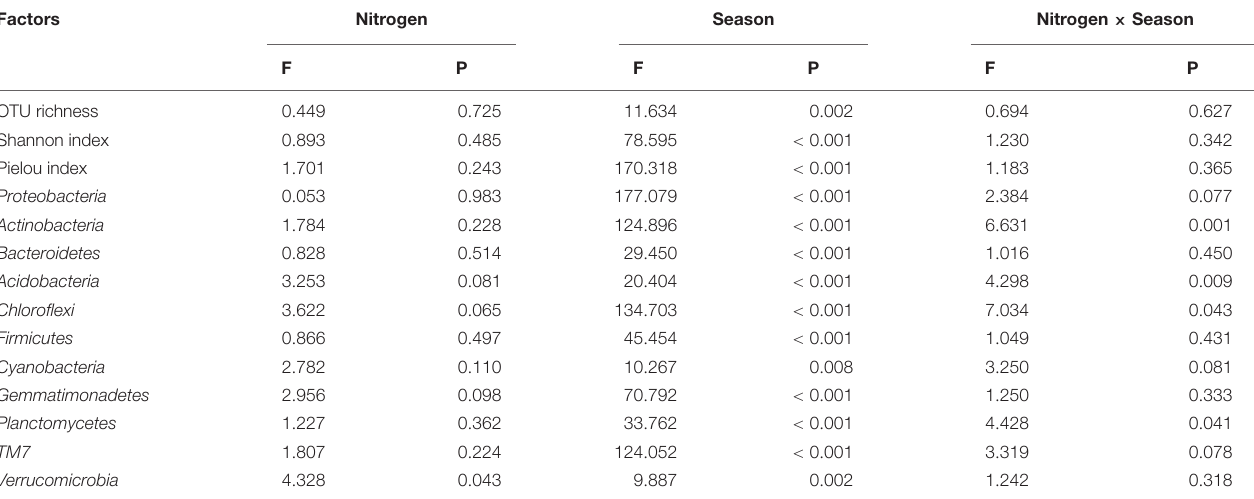
FIGURE 2 | Seasonal changes in soil bacterial OTU richness and diversities in moss crusts with different levels of N additions. OTU richness (A) , Pielou index (B) , and Shannon index (C) . N0 = 0 g N m - 2 year - 1 ; LN = 1.8 g N m - 2 year - 1 ; MN = 3.6 g N m - 2 year - 1 ; HN = 7.2 g N m - 2 year - 1 . Different capital letters indicate a significant difference among the three sampling months with the same concentration of N; different lowercase letters indicate a significant difference among four N treatments in the same sampling month. Vertical bars show the standard error (SE) ( n = 3). TABLE 2 | Effects of nitrogen addition, season, and their interactions on soil bacterial diversity as indicated by two-way ANOVA statistics, based on the relative abundance of phyla level. Factors Nitrogen Season Nitrogen ×